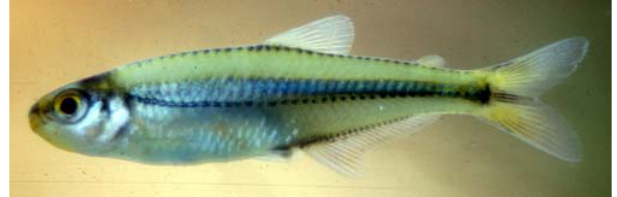
Fig. 3. Bryconadenos tanaothoros , new species, MCP 30516, SL 32.0 mm, adult female. Brazil: Mato Grosso, córrego Tatu, on the road MT-423, GPS coordinates 11°28’36"S 54°58’47"W. Adult female freshly fixed in formalin. The dark chromato- phores of this specimen associated with the lateral line are displayed almost evenly throughout the lateral line’s length. The anal fin shows no evidence of a